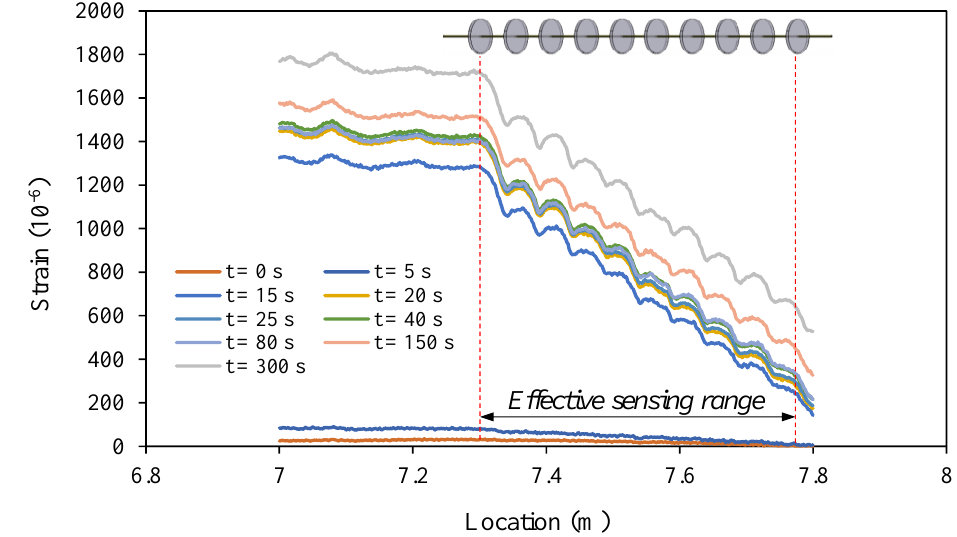
Figure 4. Typical strain distributions along the OFDR coin sensor.